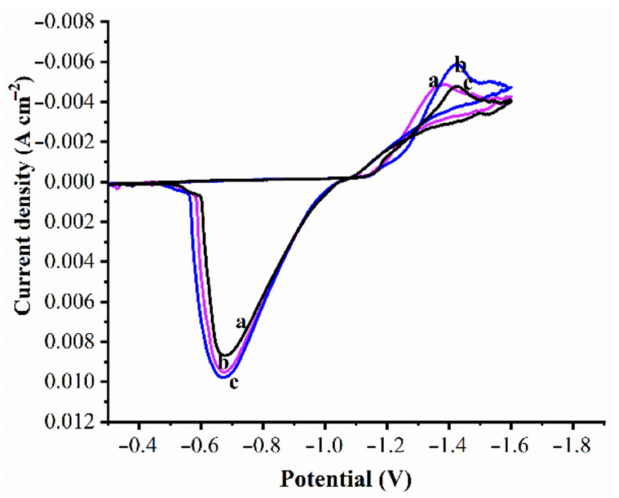
Figure 4. Cyclic voltammograms for ( a ) Zn ( b ) Zn–WO 3 (0.5 g/L) and ( c ) Zn–WO 3 (1.0 g/L) plating